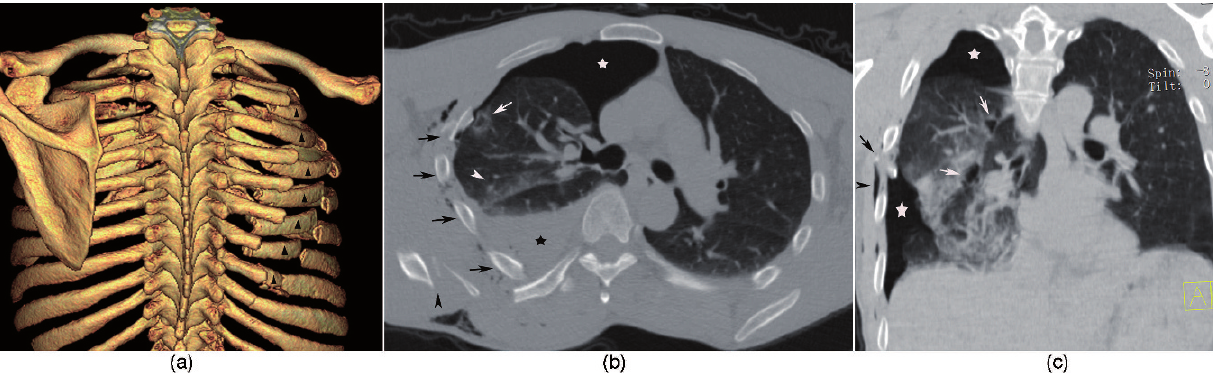
Figure 2 - Flail chest in a 46-year-old man. ( 2A ) The surface-shaded display shows thoracic cage asymmetry caused by right-side rib 2–8 fractures at multiple sites causing flail chest ( m ), and fractures of right-side ninth rib of posterior location. ( 2B ) The axial CT scan shows a right-side hemothorax ( w ), pneumothorax ( q ), and pulmonary parenchymal injuries, including contusion (write arrowhead) and laceration (write arrow), thoracic cage asymmetry caused by right-side rib fractures (black arrows), and a right scapular fracture (black arrowhead). Right-side subcutaneous air collection is also depicted. ( 2C ) The coronal multi-planar reconstruction shows a right-side pneumothorax ( q ), a pulmonary parenchymal laceration (write arrows) and a contusion, right-side rib fractures (black arrow), and right-side subcutaneous air collection (black